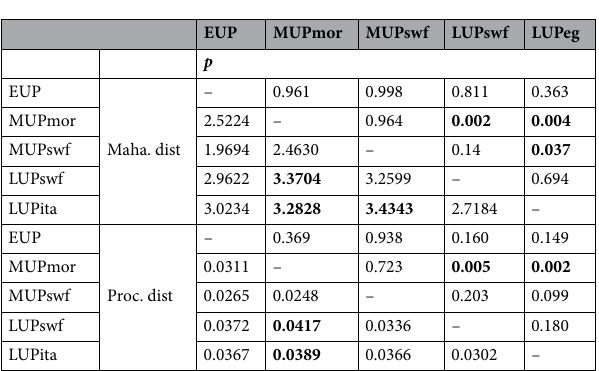
Table 4. Mahalanobis distances between the groups calculated from the aligned 3D coordinates and associated p-values from permutation tests (10,000 permutations rounds).